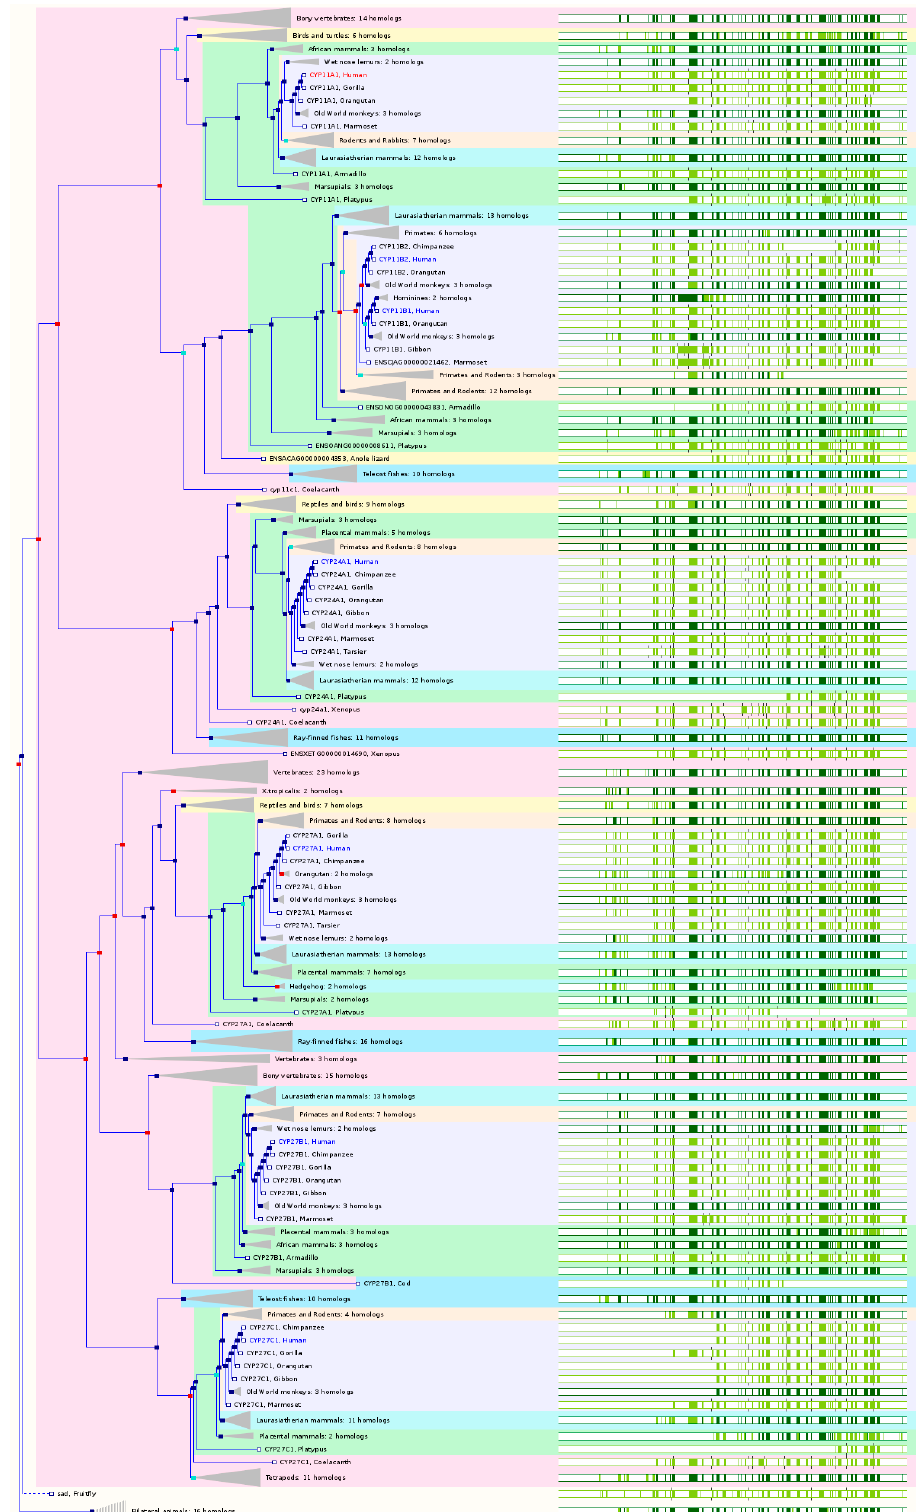
Figure 6. Cont. Figure 6.